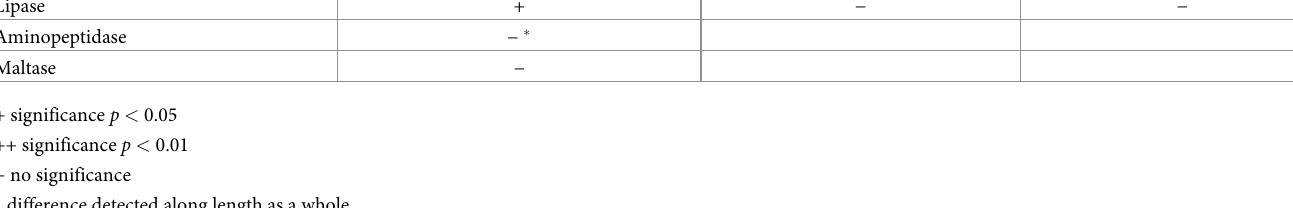
Within Anterior